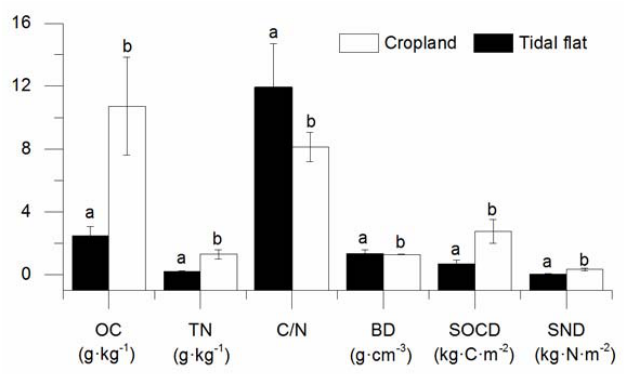
(Table 2). The SOCD of the cropland (2.75 kg · C · m − 2 ) was higher than that of the coastal tidal flat (0.68 kg · C · m − 2 ) ( p < 0.01). The SND of the cropland (0.33 kg · N · m − 2 ) was higher than that of the coastal tidal flat (0.05 kg · N · m − 2 ) ( p < 0.05).